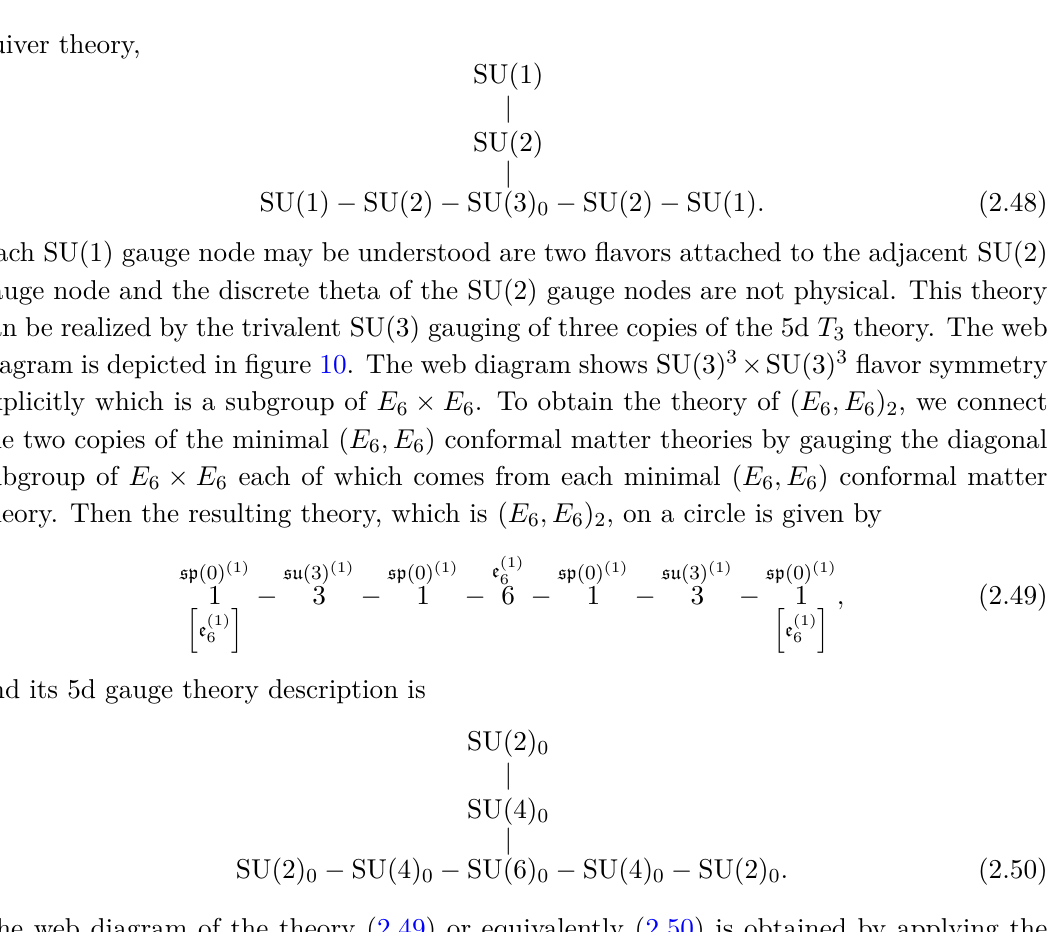
Figure 10. The web diagram for the minimal ( E 6 , E 6 ) conformal matter theory on a circle. The trivalent gluing is done so that the central SU(3) gauge node has the zero CS